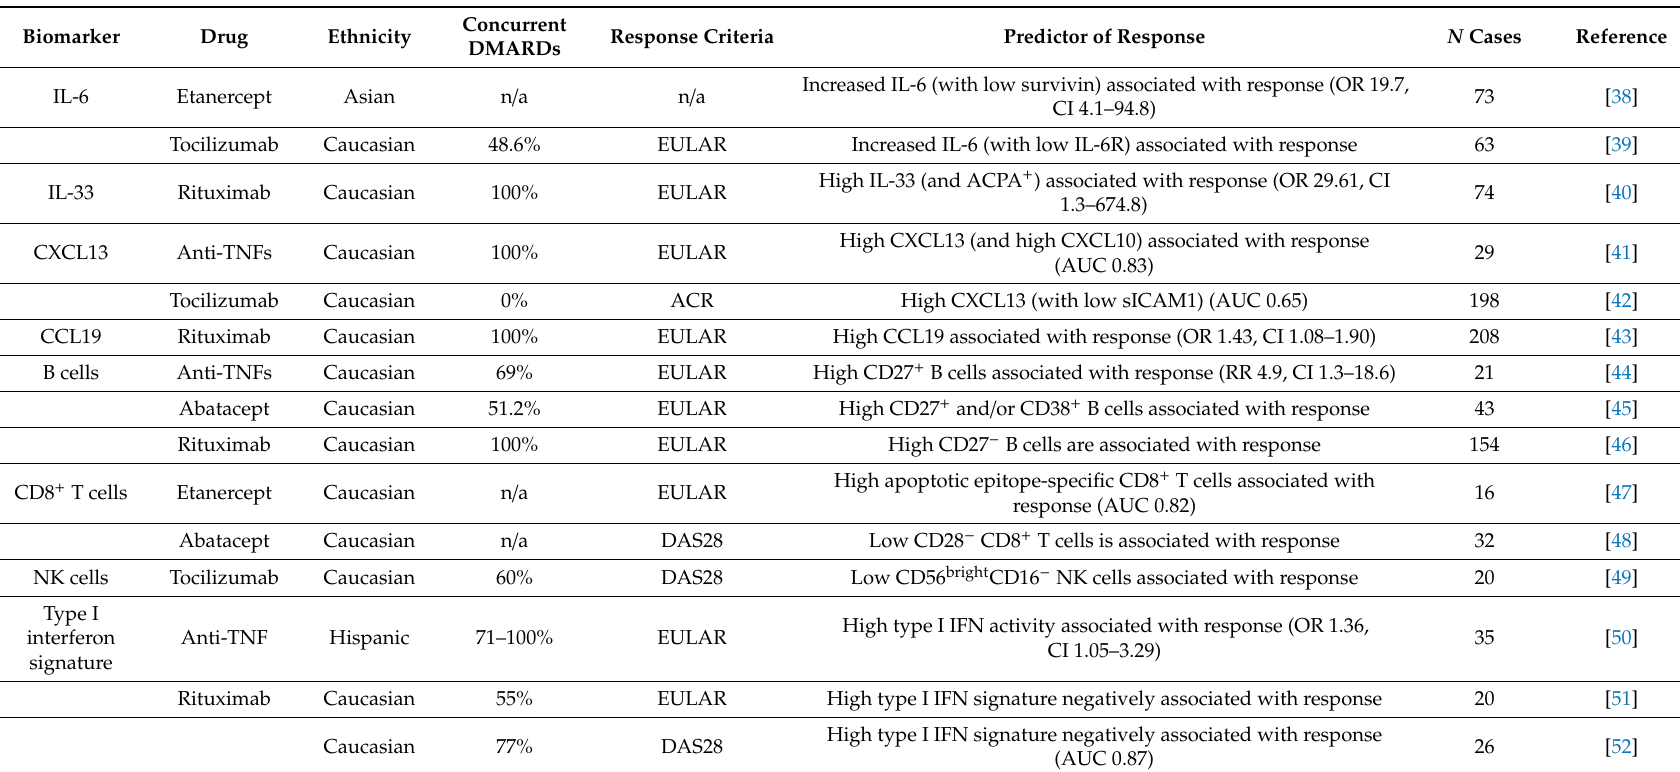
Table 1 outlines the main studies investigating immune biomarkers predicting treatment response in RA. Immune signatures are listed alongside the biologic drug studied, the ethnicity of the patient group, the percentage of the cohort taking concurrent disease-modifying anti-rheumatic drugs (DMARDs), the outcome measure used, the main findings, and the sample